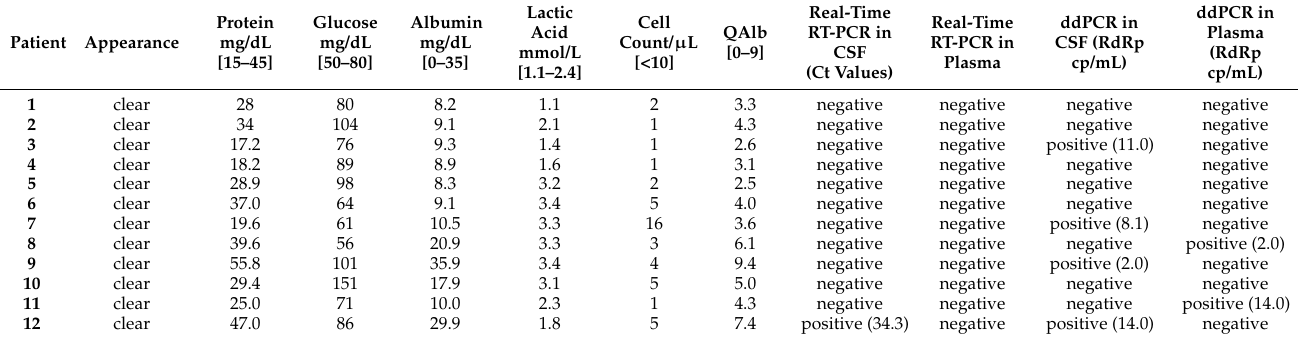
Table 3. CSF examination of neuro-COVID